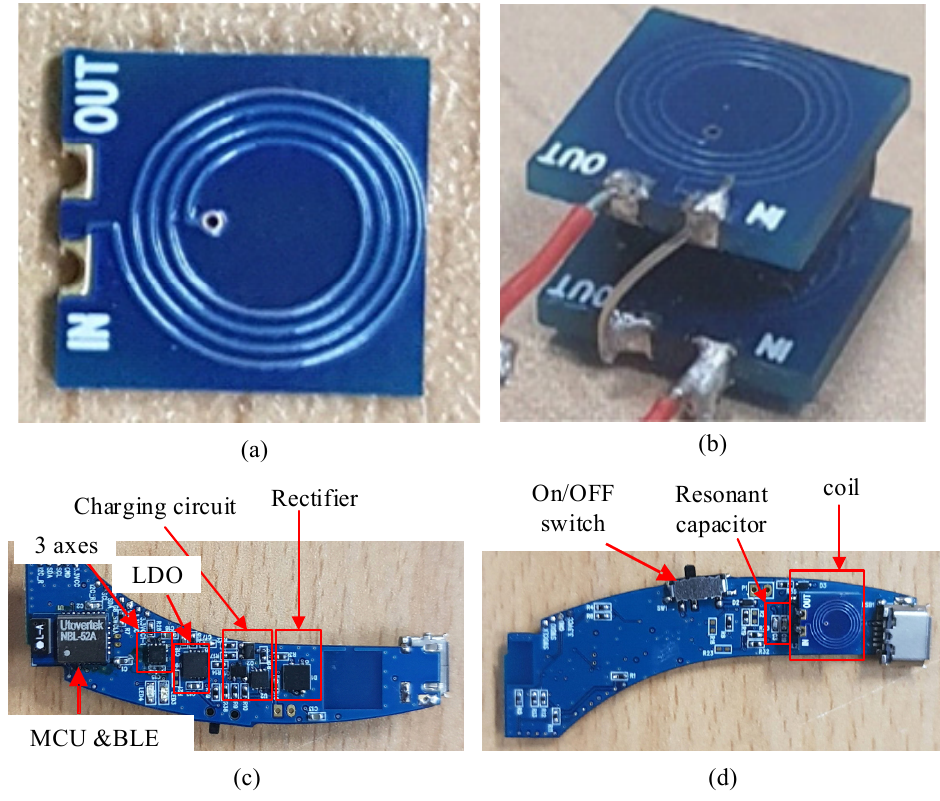
Figure 15. ( a ) Photographs of the fabricated double-layer planar spiral coil; ( b ) four-layer planar spiral coil; ( c ) circuit board of the bio-signal monitoring device;( d ) back view of the circuit board of the four-layer planar spiral coil.